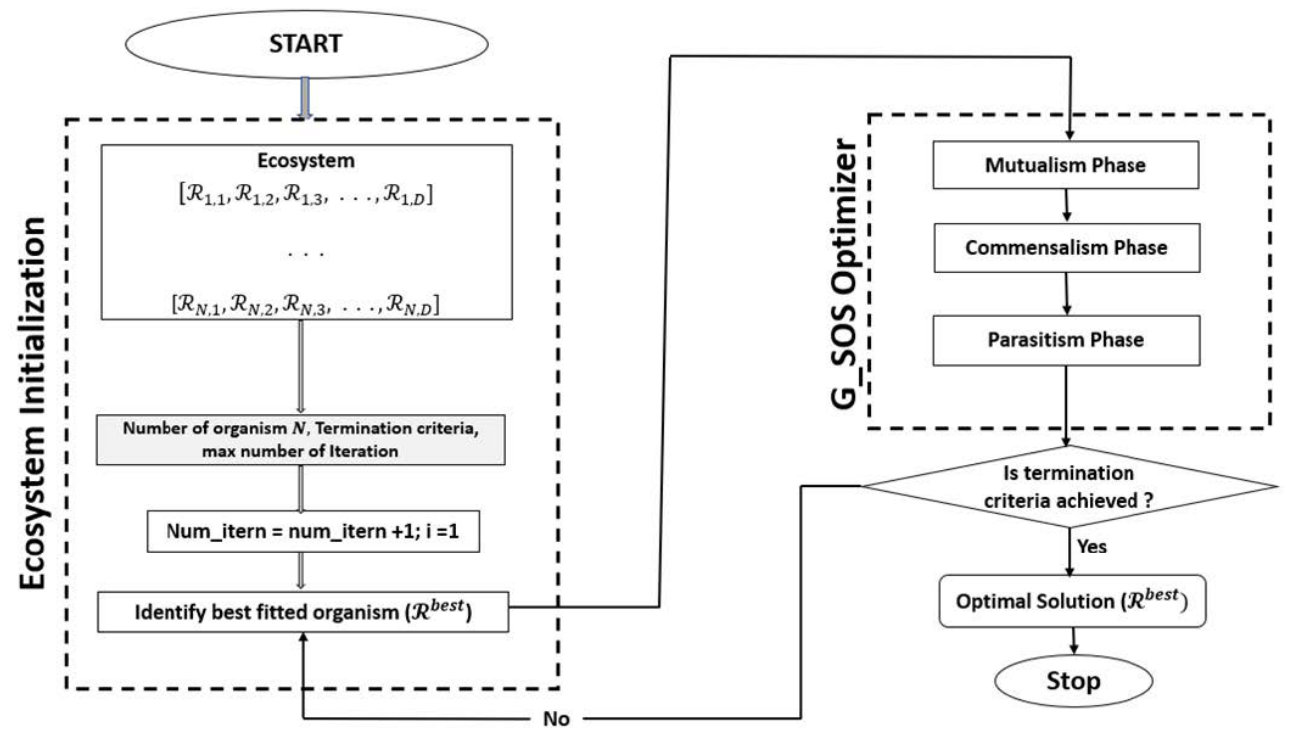
Figure 1. Flowchart of G_SOS Technique.